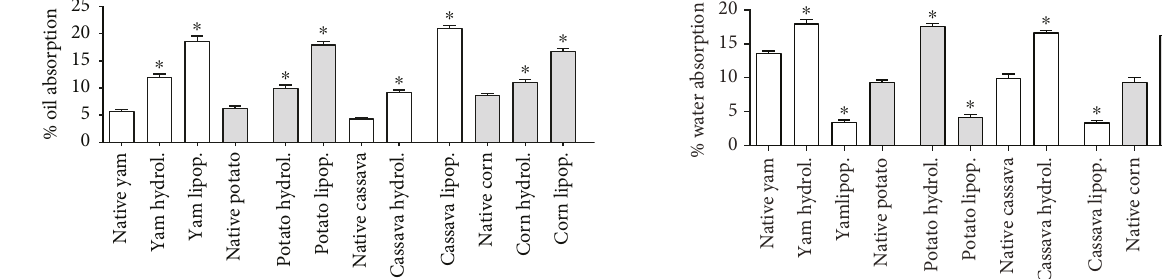
Figure 5: Graphical representation of the percentages of water capture of all starches. ∗ Signi fi cant di ff erences compared to native corn p < 0 05